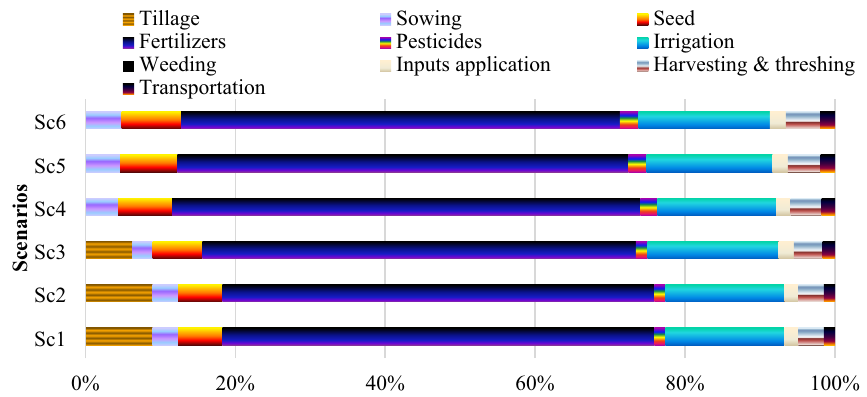
Figure 2. Operation-wise input energy-use pattern (%) under different management practices in wheat. Where; Sc1, business as usual or conventional tillage (CT) without residue; Sc2, CT with residue; Sc3, reduce tillage (RT) with residue + recommended dose of fertilizer (RDF); Sc4, RT/Zero tillage (ZT) with residue + RDF; Sc5, ZT with residue + RDF + GreenSeeker + Tensiometer; Sc6, Sc5 + Nutrient expert.